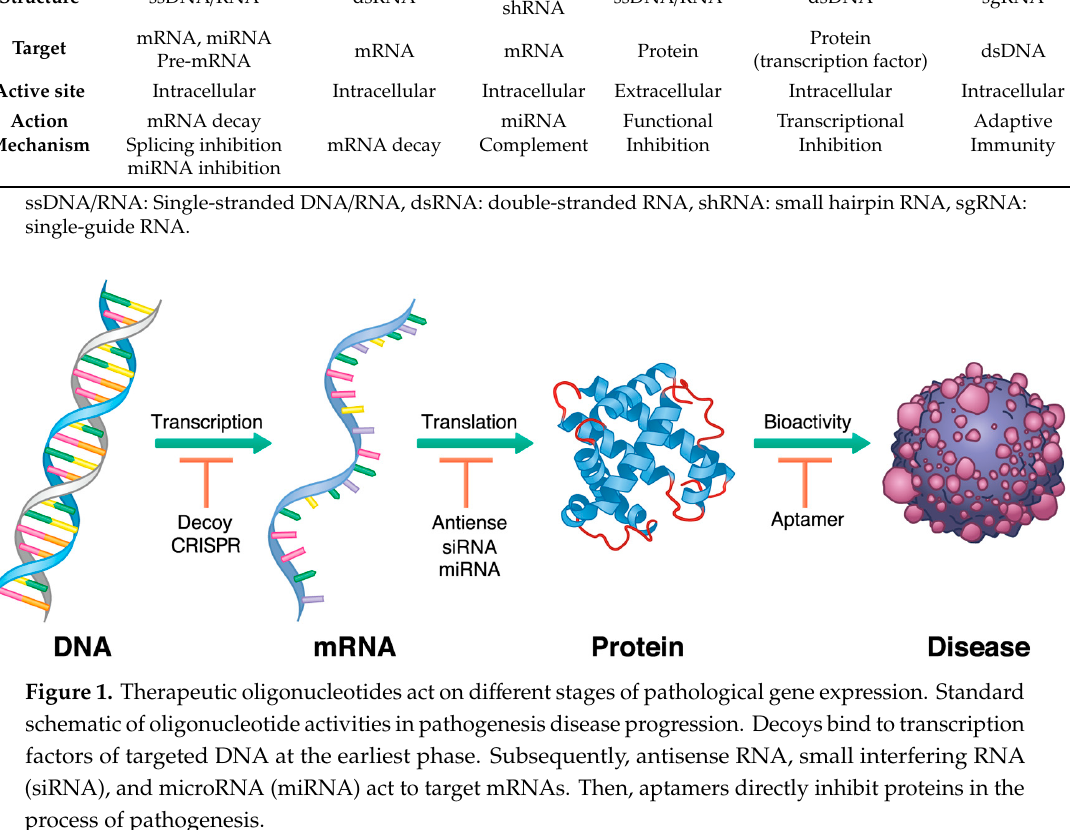
Table 2. Classification of oligonucleotide therapeutics.